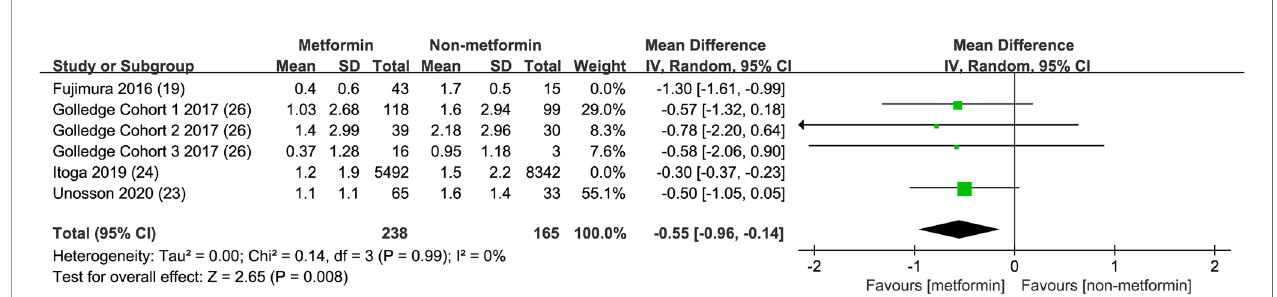
FIGURE 6 | Assessment of the effect of metformin on incidence of AAA. Forest plot of studies assessing the effect of metformin on incidence of AAA events.